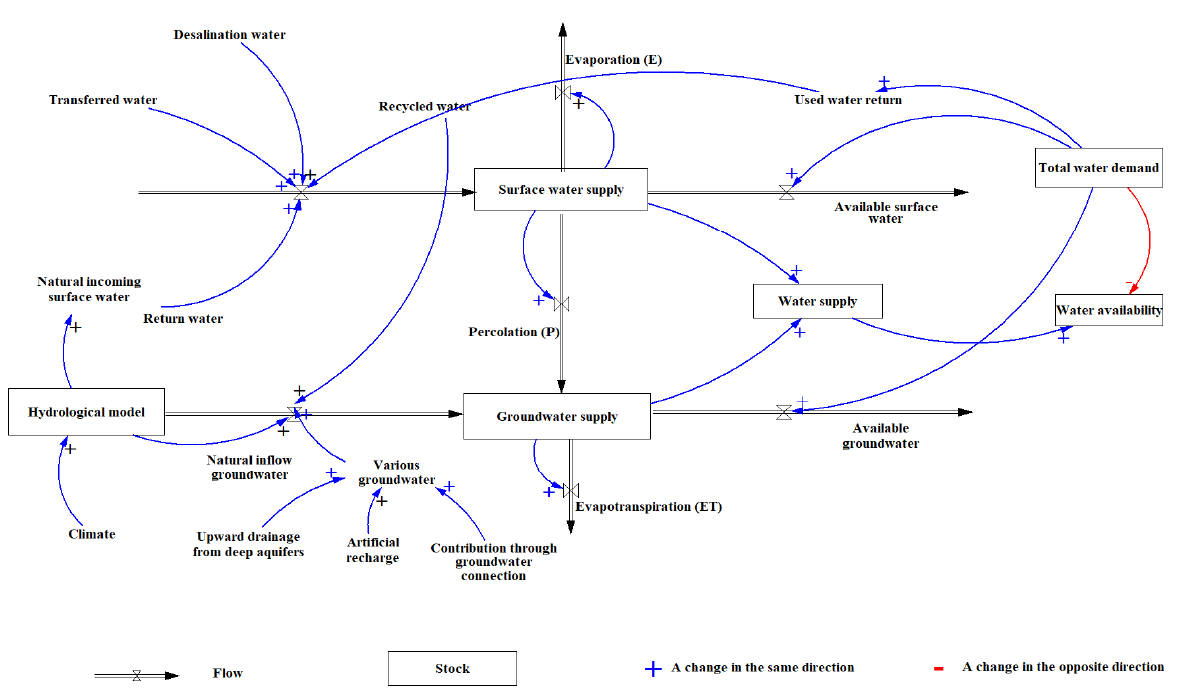
Figure 5. Stock–flow diagram showing the interactions between key water supply parameters in the Figure 5. Stock– fl ow diagram showing the interactions between key water supply parameters in the Souss-Massa Souss-Massa basin.